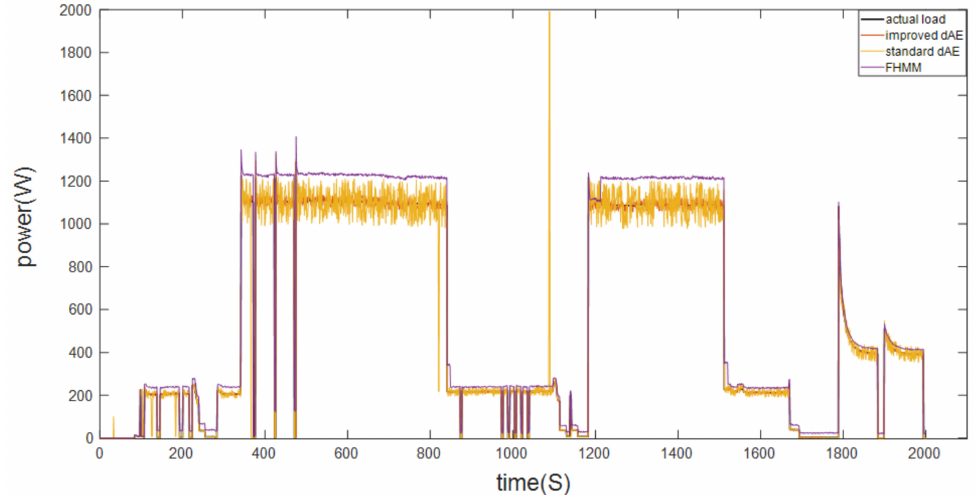
Figure 6. Actual energy consumption of dishwasher in Household 1 in one day.